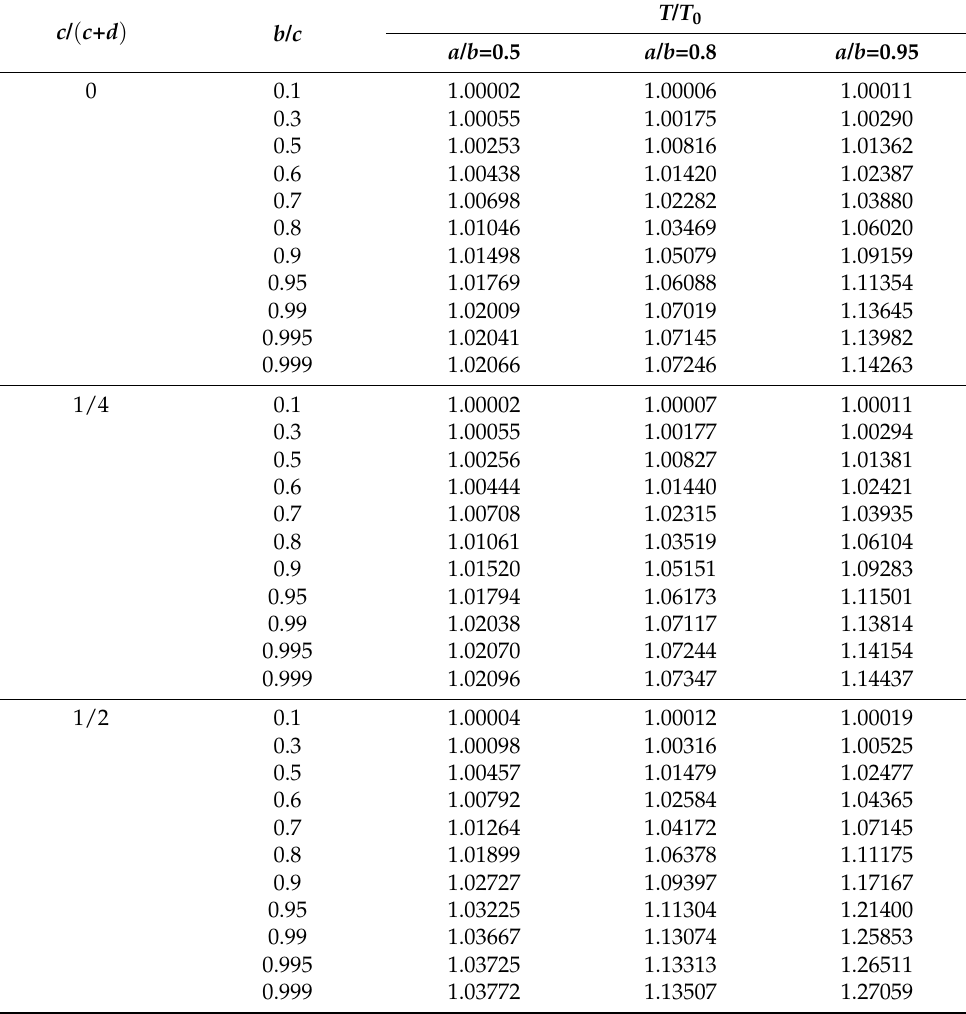
Table A2. Normalized torque T / T 0 for a soft sphere with λ b = 1 rotating about a diameter perpen- dicular to two parallel planar